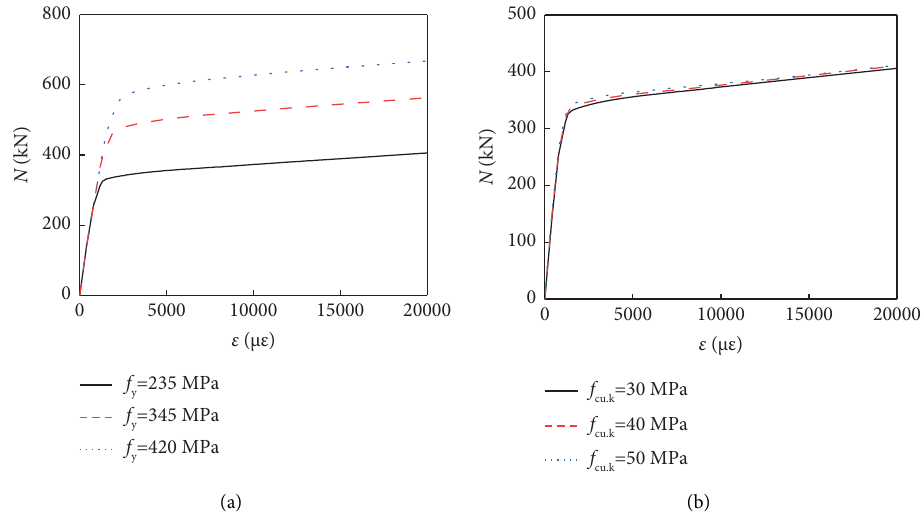
Figure 20: Te infuence of f y and f cu · k on the axial tensile properties: (a) N-ε curve of specimen under diferent f y and (b) N-ε curve of specimen under diferent f cu · k